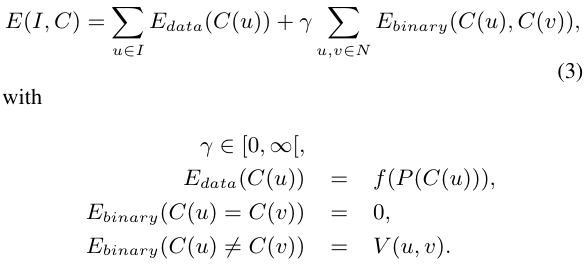
Figure 6. Difference between the pixel-based feature map and the object-based feature map of the sub area of Figure 4(b). Black color corresponds to low vegetation density area and white color to high vegetation density